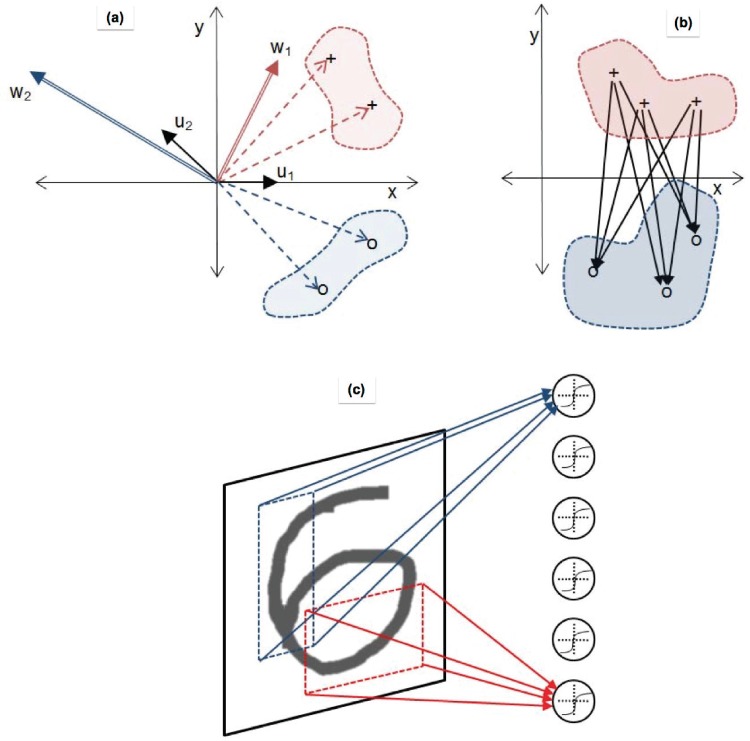
Illustration of the three core methods of shaping ELM input weights.In (a), which is a cartoon of the Computed Input Weights ELM (CIW-ELM) process [15], two classes of input data are indicated by ‘+’ and ‘o’ symbols. The vectors to the ‘+’ symbols are multiplied by random bipolar binary {−1, 1}) vectors u
1 and u
2 to produce a biased random weight vector w
1. Similarly the weights to the ‘o’ class are also multiplied by random vectors u
1 and u
2 to produce a biased random weight vector w
2. Note that in practice we would not use the same random binary vectors. In (b), we show the Constrained ELM (C-ELM) process [21]. The black arrows are weight vectors derived by computing the difference of two classes; in this case, the difference between the ‘+’ elements and the ‘o’ elements. In (c), we illustrate the Receptive Field ELM (RF-ELM) method; weights for each hidden layer neuron are restriced to being non-zero for only a small random rectangular receptive field in the original image plane.